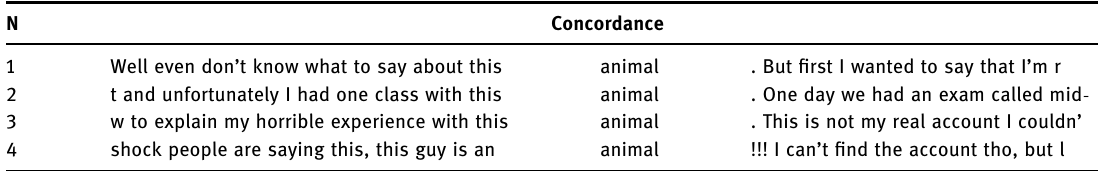
Table 14: Concordance lines for animal